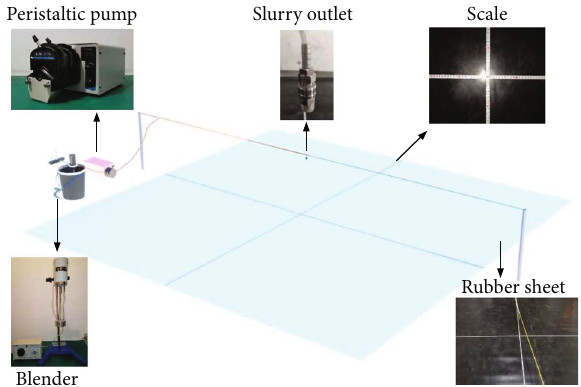
Figure 2: Experimental system of slurry di ff usion.